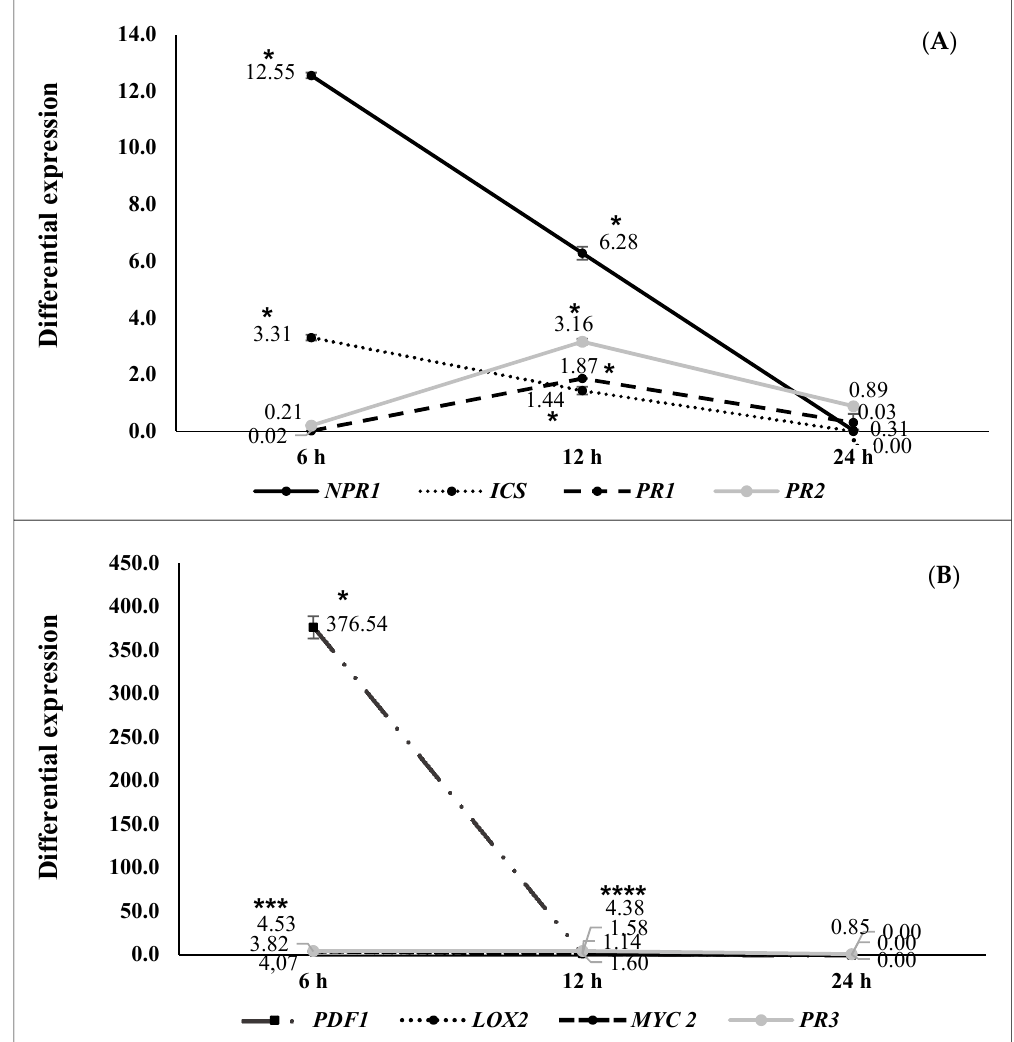
Figure 2. Differential gene expression (seedlings inoculated with N 5.12 ( Pseudomonas putida ) vs negative control) at 6 ( n = 16), 12 ( n = 16) and 24 ( n = 16) hapc; ( A ) NPR1 , ICS , PR1, and PR2 genes (as SA signaling pathway markers) and ( B ) PDF1 , LOX2 , MYC2, and PR3 (as JA/ET signaling pathway markers). Asterisks represent statistically significant differences ( p < 0.05) with respect to negative control (differential expression of 1).